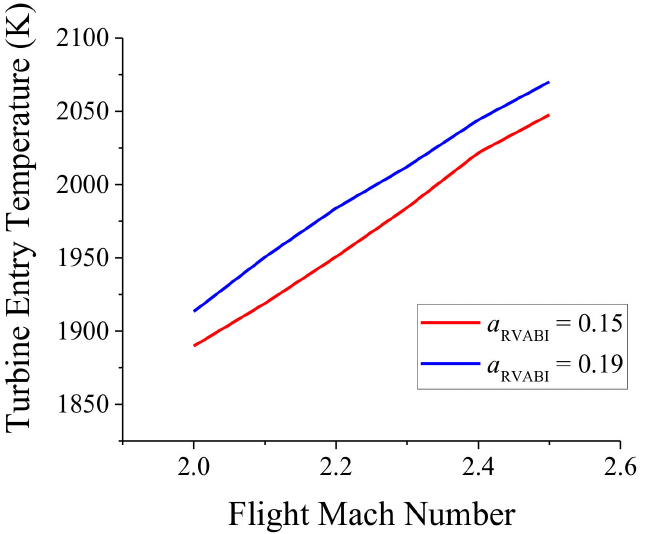
Figure 28. The Variations of Turbine Entry Temperature at the conditions of Different Area Coeffi- cients of RVABI ( α RVABI ).